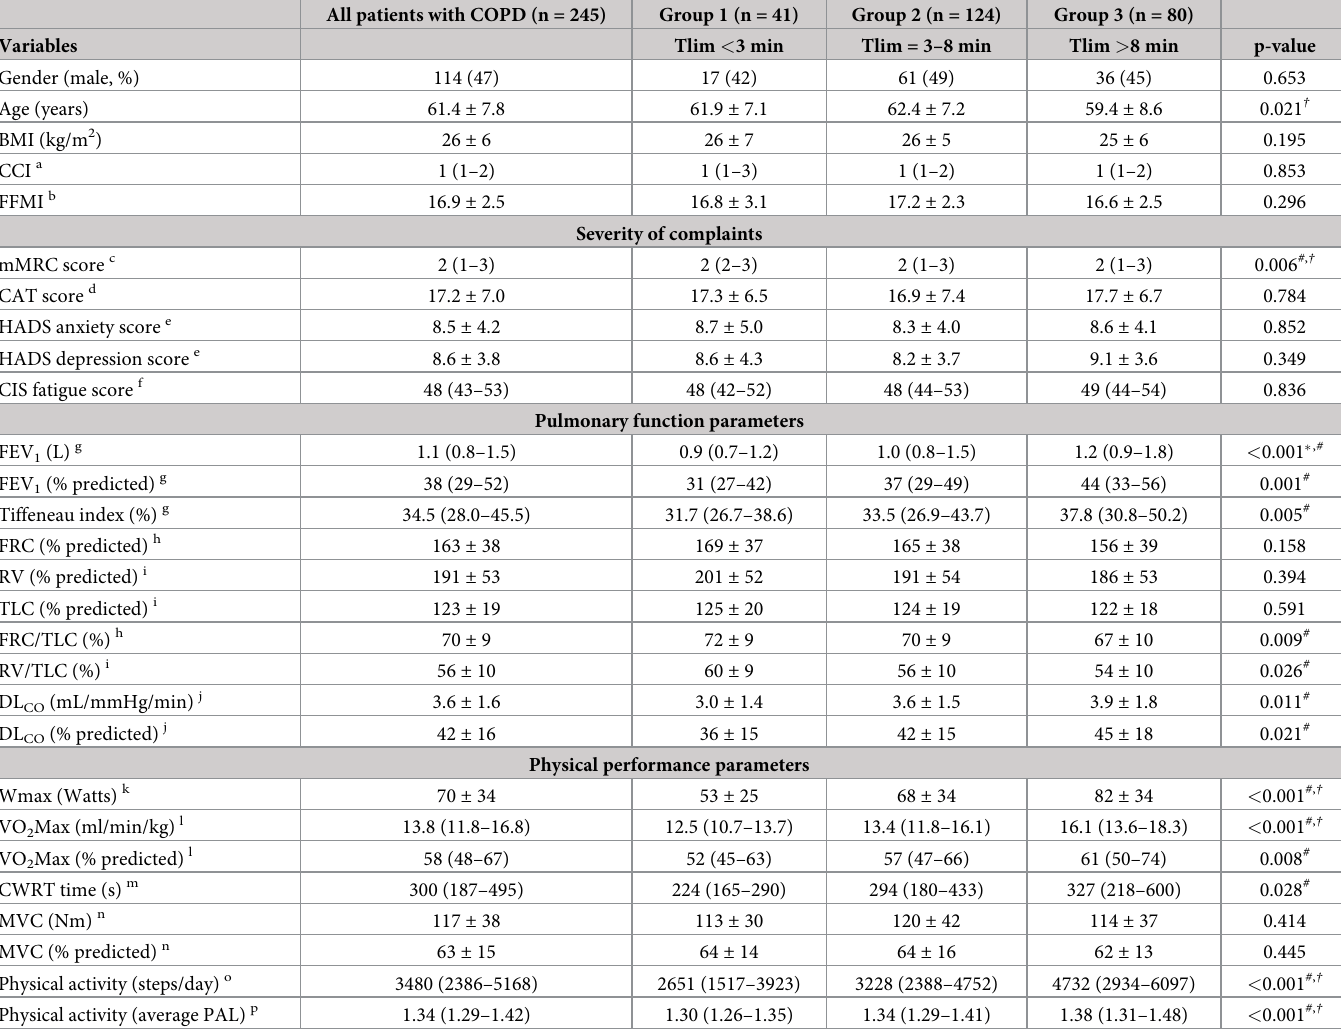
Table 1. Subject characteristics, severity of complaints and parameters of pulmonary function and physical performance of the whole group and the three sub- groups based on tolerated duration during the ESWT. All patients with COPD (n =